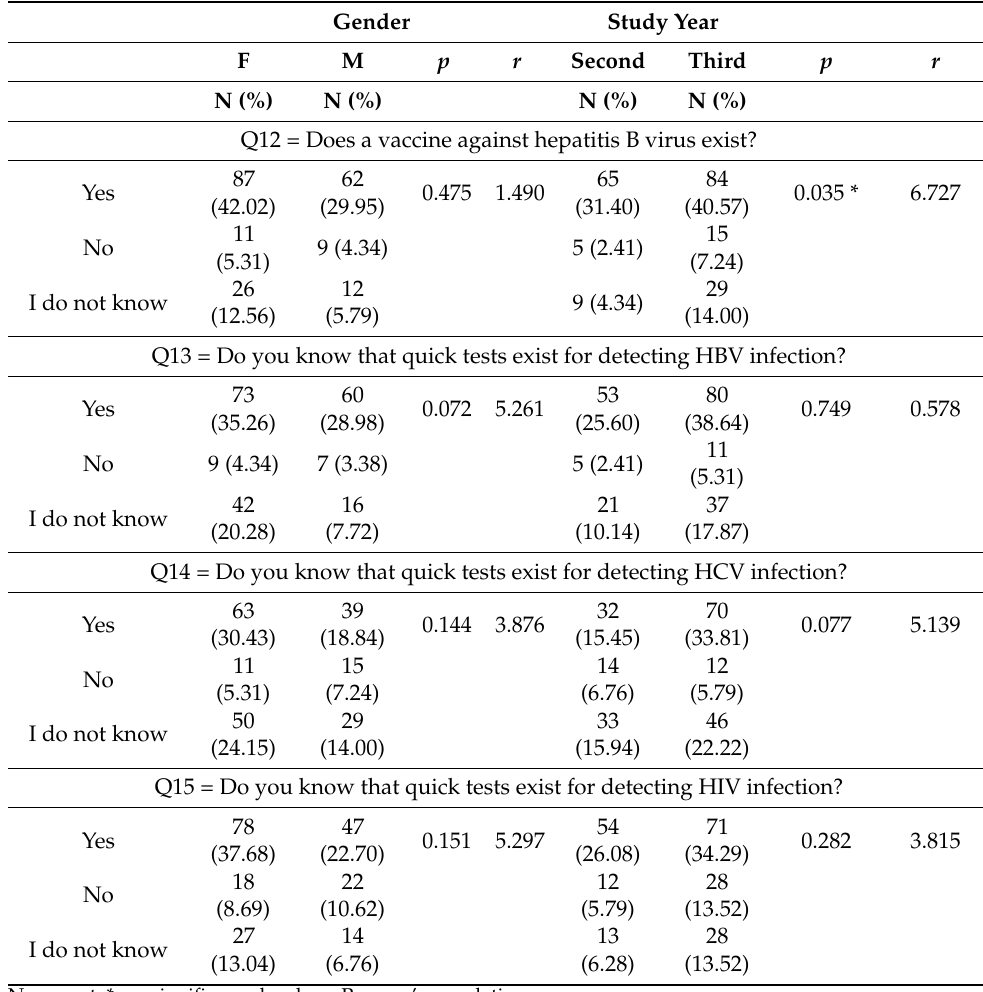
Table 3. Assessing the perception of the knowledge level about the existence of the HBV vaccine and rapid tests for HBV, HCV, and HIV infections. Comparative data and Chi-square